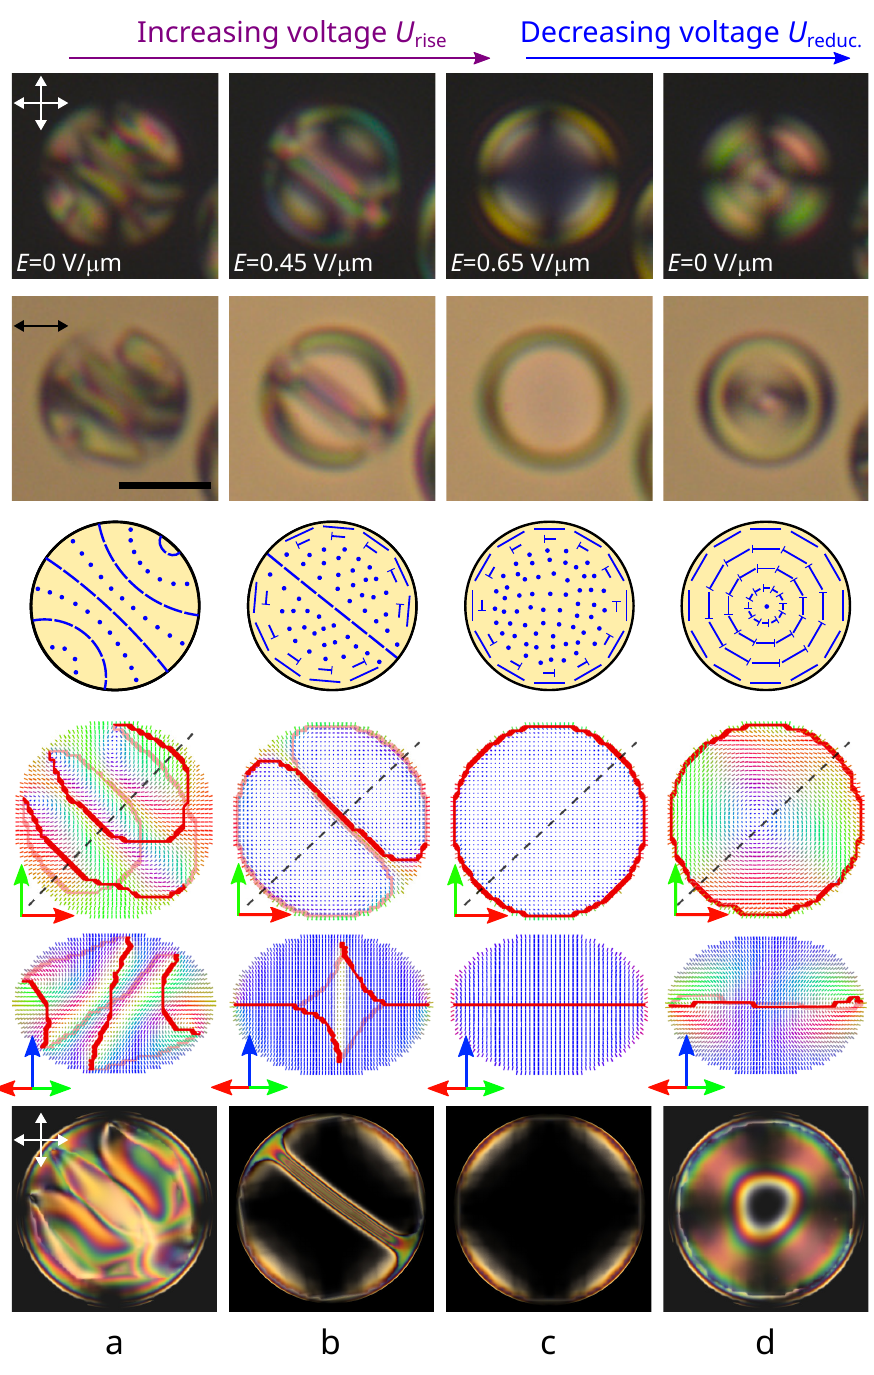
Figure 1. The initial N 0 = 6.3 structure with a bipolar distribution of the cholesteric axis ( a ), droplet under an electric field E rise equal to 0.45 V/ µ m ( b ) and 0.65 V/ µ m ( c ) when voltage is increased, and the droplet after an electric field is switched off ( d ). POM photos taken with the crossed polarizers ( top row ) and with one polarizer ( second row ); schemes of the director in the droplet cross-section ( third row ); calculated director distributions at the top view ( fourth row ) and side view ( fifth row ), and the corresponding POM pictures ( bottom row ). Hereinafter, double arrows indicate the directions of the polarizers, and the director n is colored in correspondence with the direction (red along the x -axis, green along the y -axis, blue along the z -axis). The scale bar is 10 µ